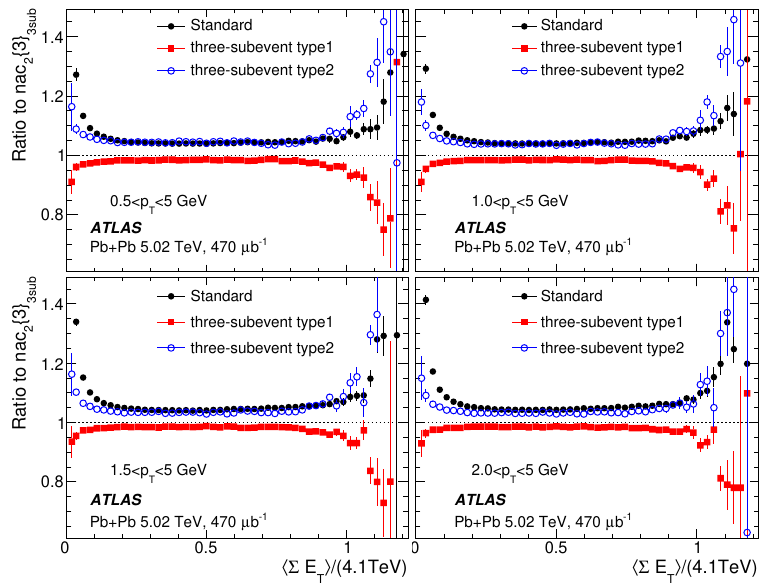
Figure 33 . The ratio of nac 2 f 3 g from the standard method (solid circles), three-subevent method with V 4 de(cid:12)ned in subevent a or c (solid squares, type1) and three-subevent method with V 4 de(cid:12)ned in subevent b (open circiles, type2) to nac 2 f 3 g from the three-subevent method combined. Di(cid:11)erent panels correspond to di(cid:11)erent p T ranges. Only statistical uncertainties are shown.